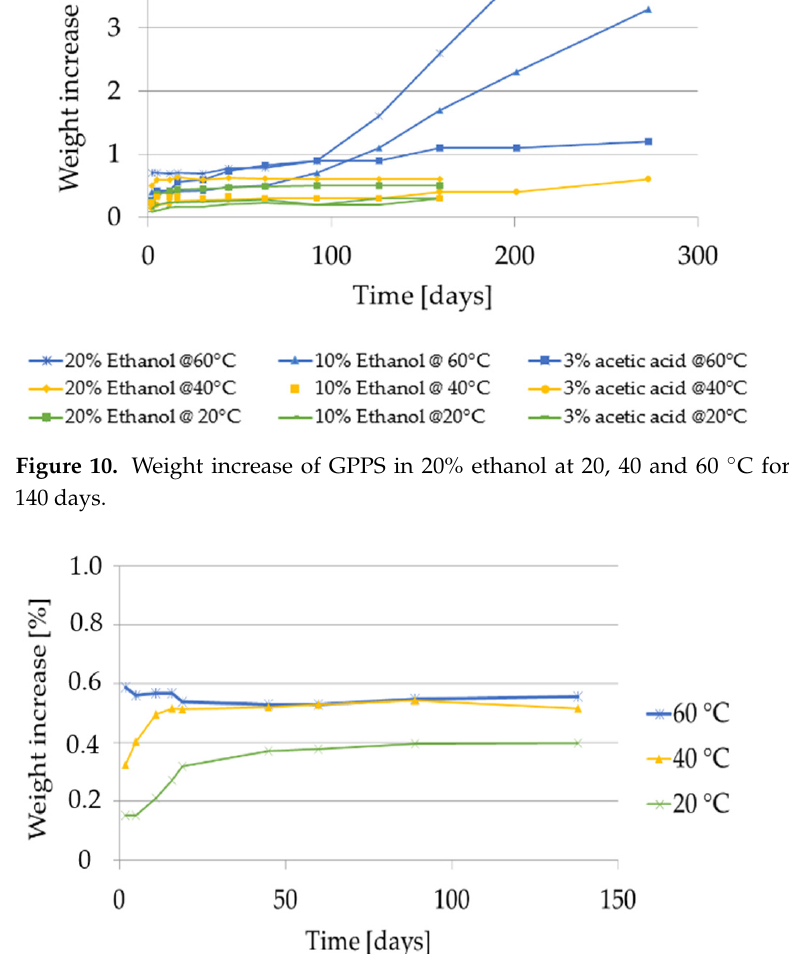
Figure 11. Weight increase of HIPS in aqueous food simulants at 20, 40 and 60 ◦ C for storage times